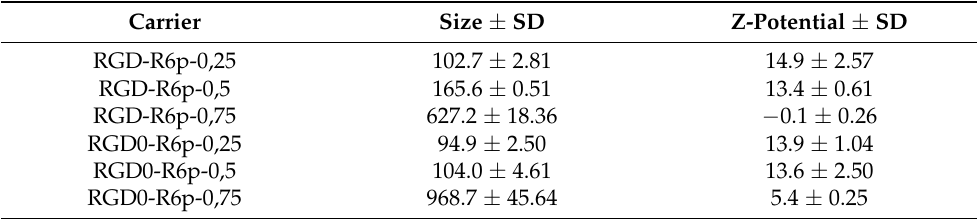
Table 2. Size and zeta-potential of carrier/DNA complexes at N/P ratio 8/1. The data are shown as the mean ±